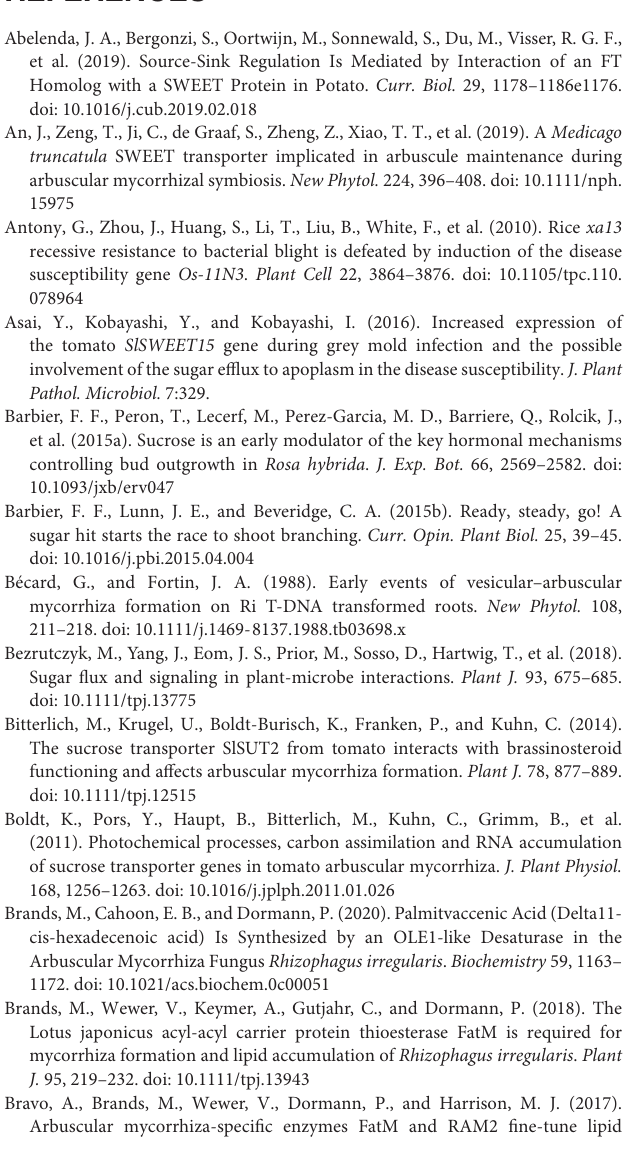
Supplementary Figure 2 | Representative pictures of plant roots infected with Fusarium oxysporum f. sp. tuberosi in plants expressing StSWEET7a or an empty vector (EV). Confocal microscopy pictures showing F. oxysporum f. sp. tuberosi colonization 7 weeks post inoculation in four different transgenic lines for each treatment. The fungus was stained with WGA-FITC (left, bright field; center, green channel; right, overlay). Scale bar corresponds to 200 µ